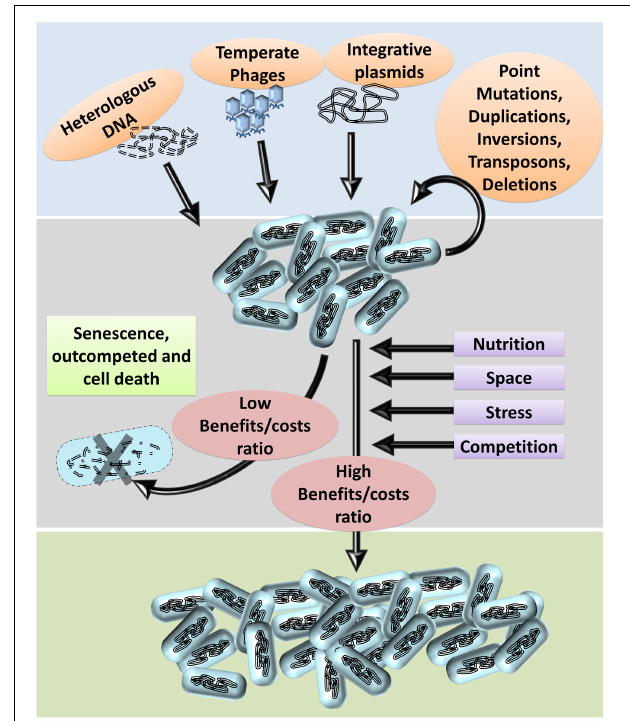
FIGURE 1 | Bacterial genome evolution. Based on the habitat, bacterial genomes acquire DNA (genetic information) from the environment. Genetic information from the phages, plasmids, and dead organisms maybe integrated into the genome by homologous or non-homologous